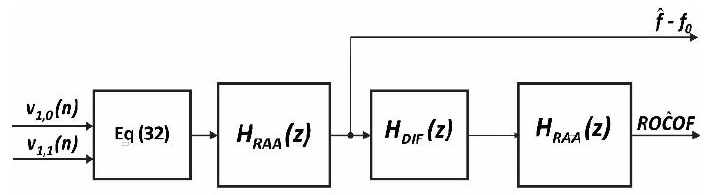
Figure 4. Block diagram of the frequency and ROCOF estimator.